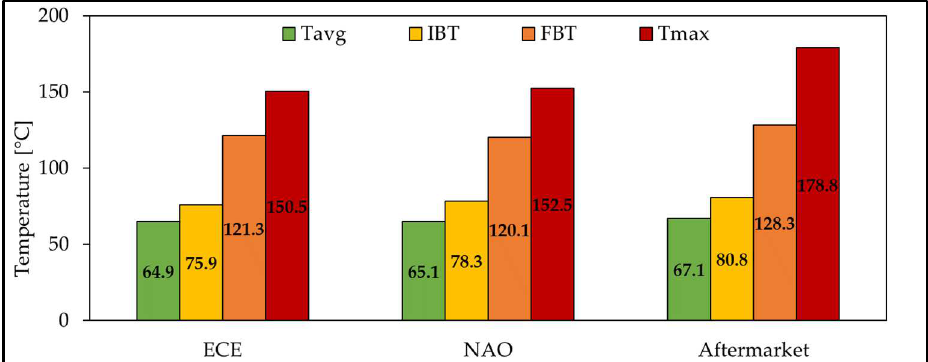
Figure 6. Temperatures of the three different brake pad compositions during WLTP Brake Cycle Trip 10. Tavg—average cycle temperature (Trip 10); IBT—initial brake temperature (reference brake events); FBT—final brake temperature (reference brake events); Tmax—maximum brake tempera- ture.